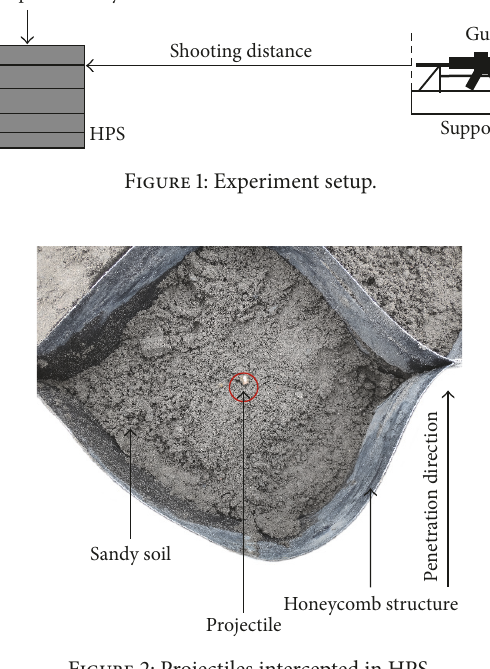
Figure 2: Projectiles intercepted in HPS.